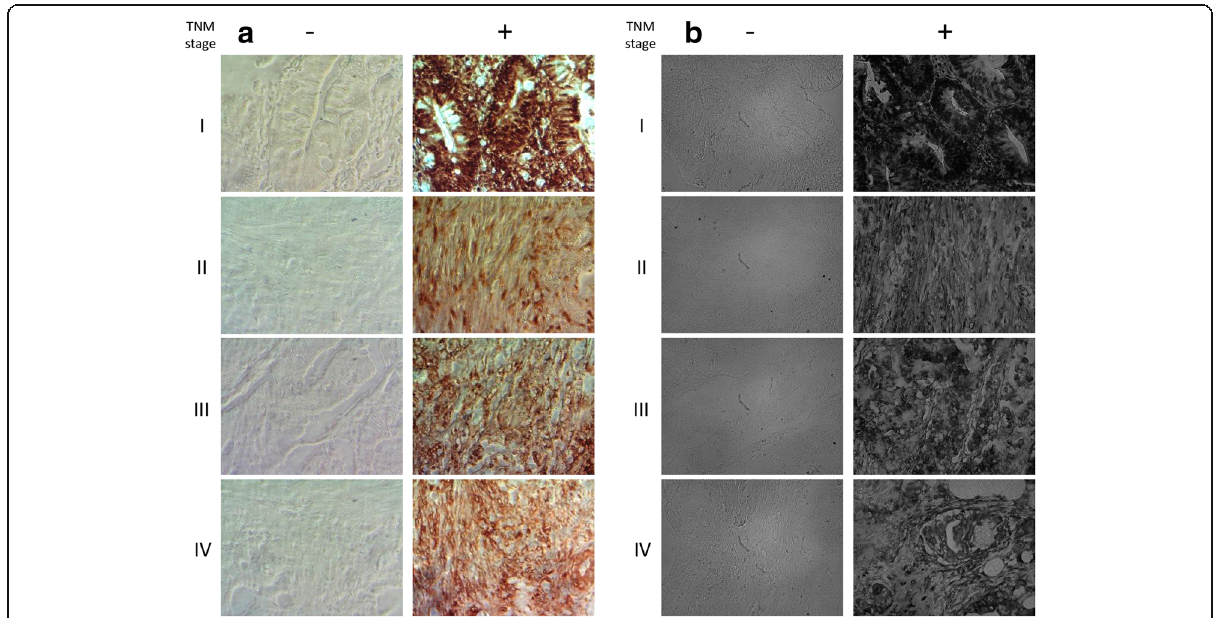
Fig. 1 GAPDH expression in colorectal tumours in different stage of progression. a Representative colour photomicrographs presenting immunohistochemical staining ( brown ) for GAPDH in colorectal tumours (x200). Stained tissues at different stages of progression are displayed in the right column and homologous areas in negative controls in the left column . b Representative monochromatic photomicrographs were analysed with ImageJ software to quantify immunostaining and assess GAPDH expression (x150). Stained tissues at different stages of progression are portrayed in the right column and homologous areas in negative controls in the left column . For both ( a ) and ( b ), representative photomicrographs used were from sample 7058 for stage I, sample 7020 for stage II, sample 7112 for